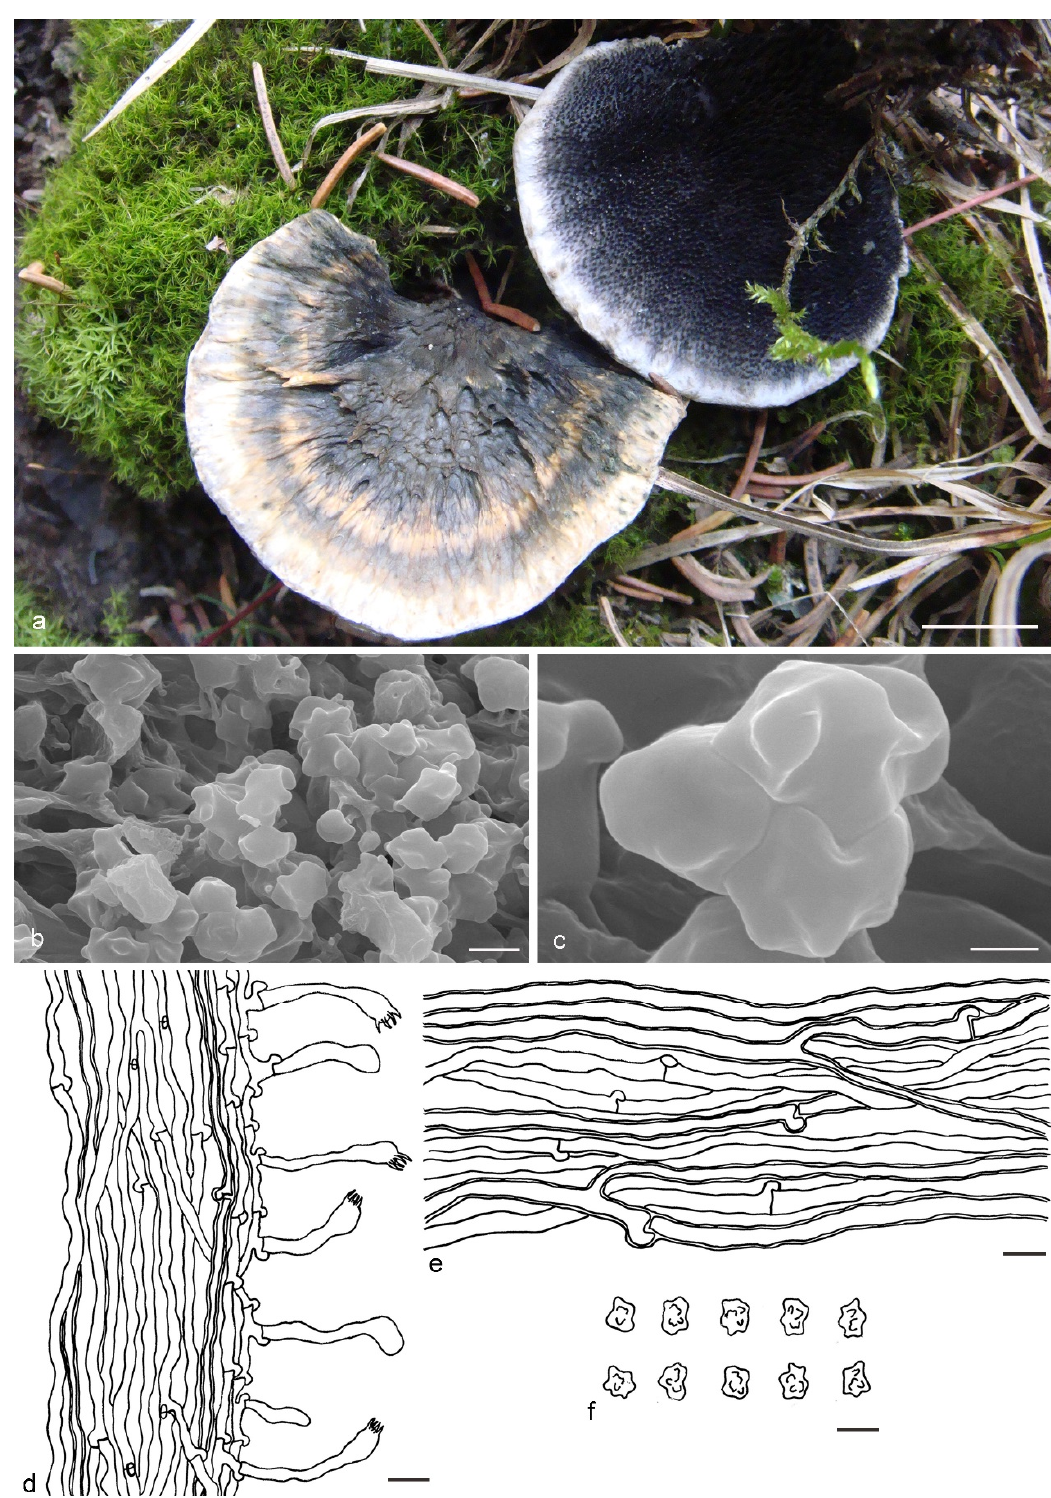
Figure 3. Hydnellum atrospinosum. ( a ): Basidiocarps; ( b , c ): SEM of basidiospores; ( d – f ): Microscopic structures (drawn from IFP 018516); ( d ): Section of hymenophore trama with basidia; ( e ): Hyphae from pileus context; ( f ): Basidiospores. —Scale bars: ( a ) = 1 cm; ( b ) = 3 μm; ( c ) = 1 μm; ( d , e ) = 10 μm; ( f ) = 5 μm. Hydnellum subg. Caesispinosum Y.H. Mu & H.S. Yuan, subgen. nov. MycoBank MB839034 MycoBank MB841195 Etymology . Atrospinosum (Latin), refers to the dark violet Etymology. Caesispinosum (Latin), refers to the blue spines. Included species: Hydnellum cyanopodium, H. scleropodium